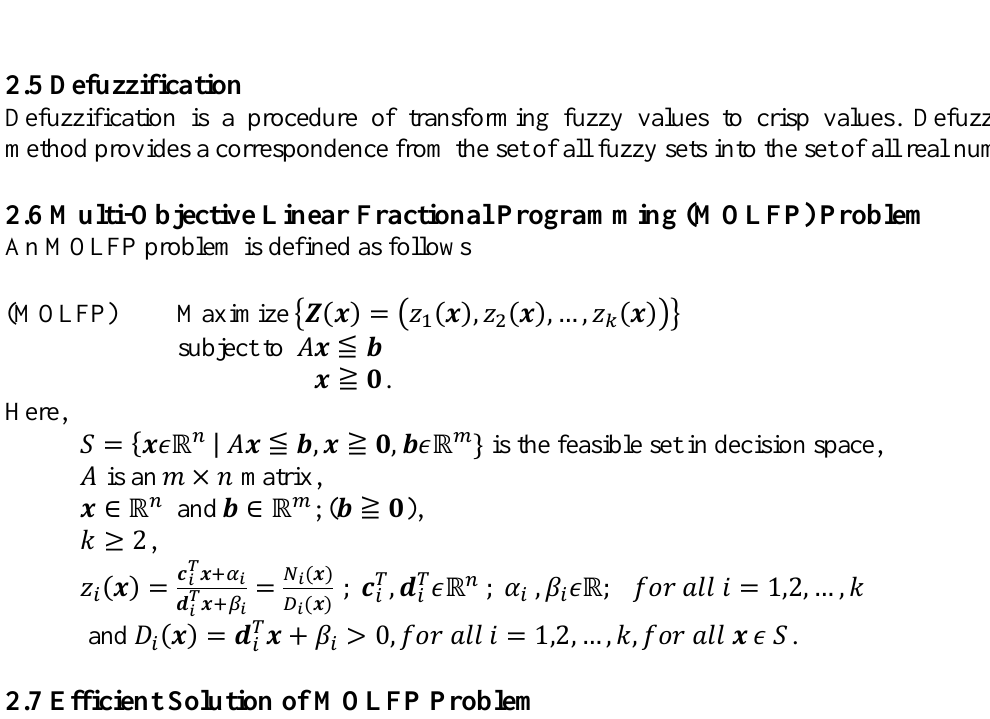
Fig. 2. Triangular fuzzy